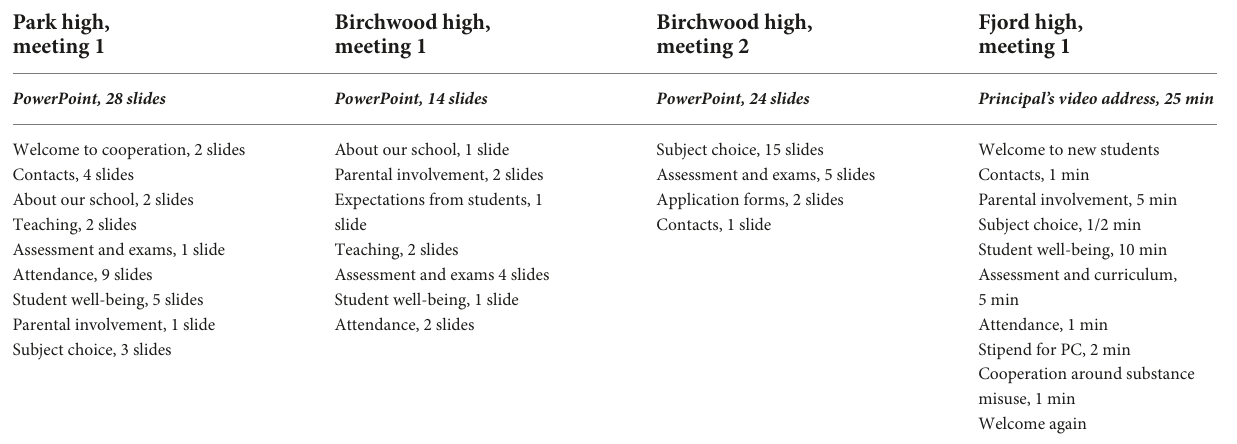
TABLE 3 Themes presented at general parent